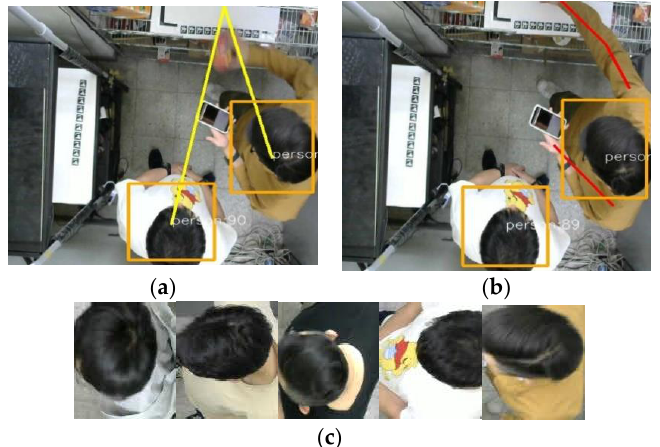
Figure 6. ( a ) Locating the event trigger by Euclidean distance; ( b ) locating the event trigger by Open- Pose; ( c ) find the customer ID in the